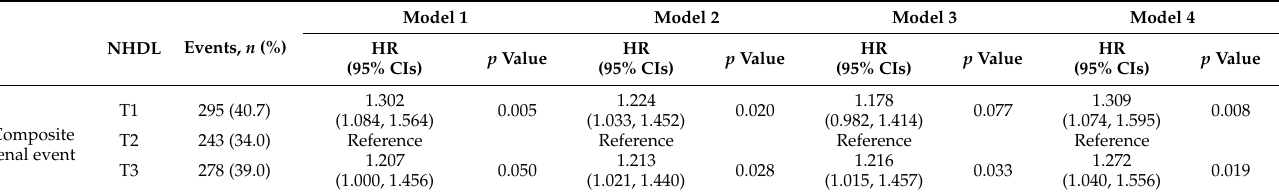
Table 2. HRs for the primary outcome by nHDL level.